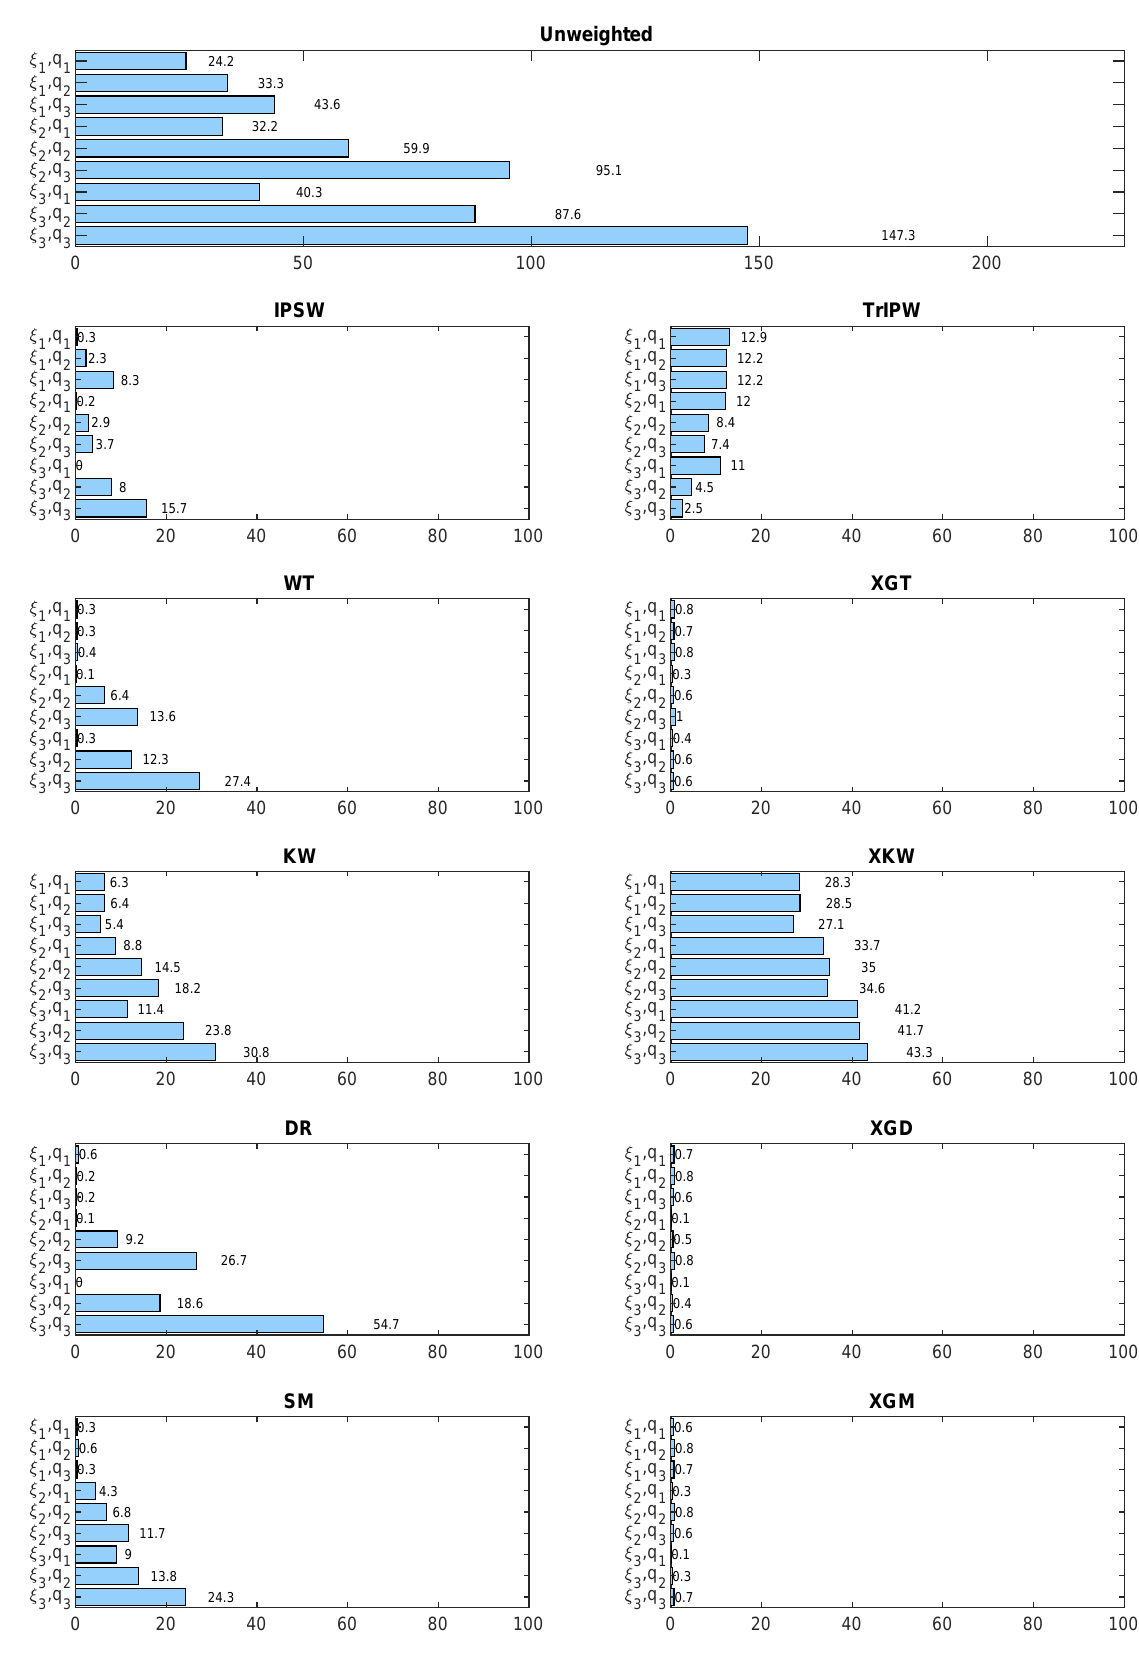
Figure 5. Relative bias (%), simulated case, correlation coefficient: